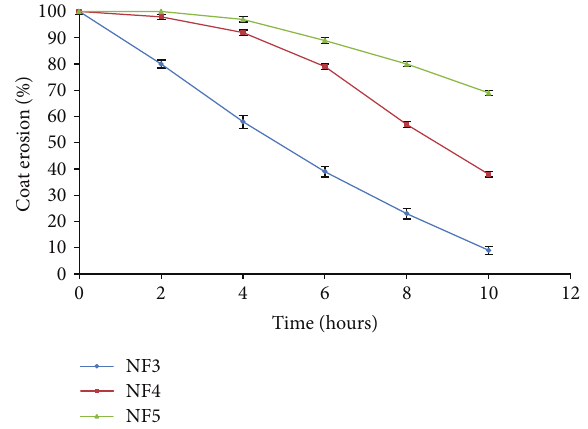
Figure 8: Coat erosion study of press-coated HPC tablets enteric coated with Eudragit S-100 in different concentrations of 2.5%, 5.0%, 7.5% (NF3, NF4, and NF5), respectively, without presence of rat caecal content. Data are expressed as mean ± S.D. ( 𝑛 = 3 ).